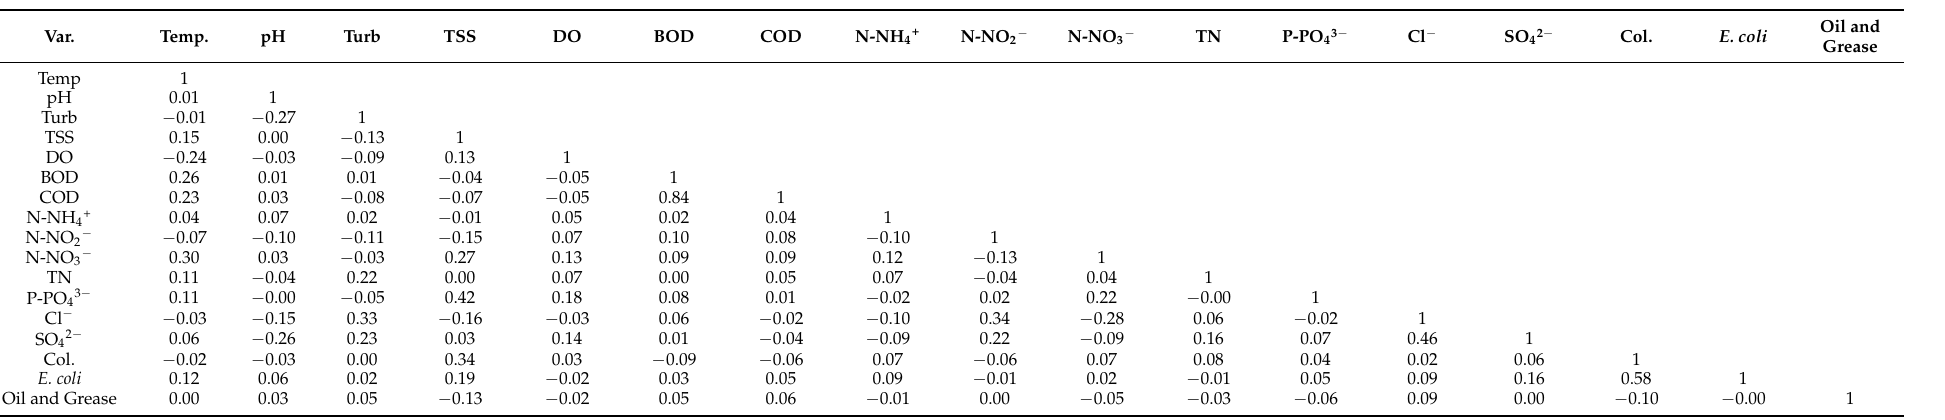
Table 1. Correlation among water variables in water bodies in Dong Thap